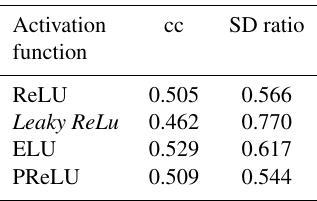
Table B3. Different activation functions, with the rest of the param- eters fixed as in Table B1.